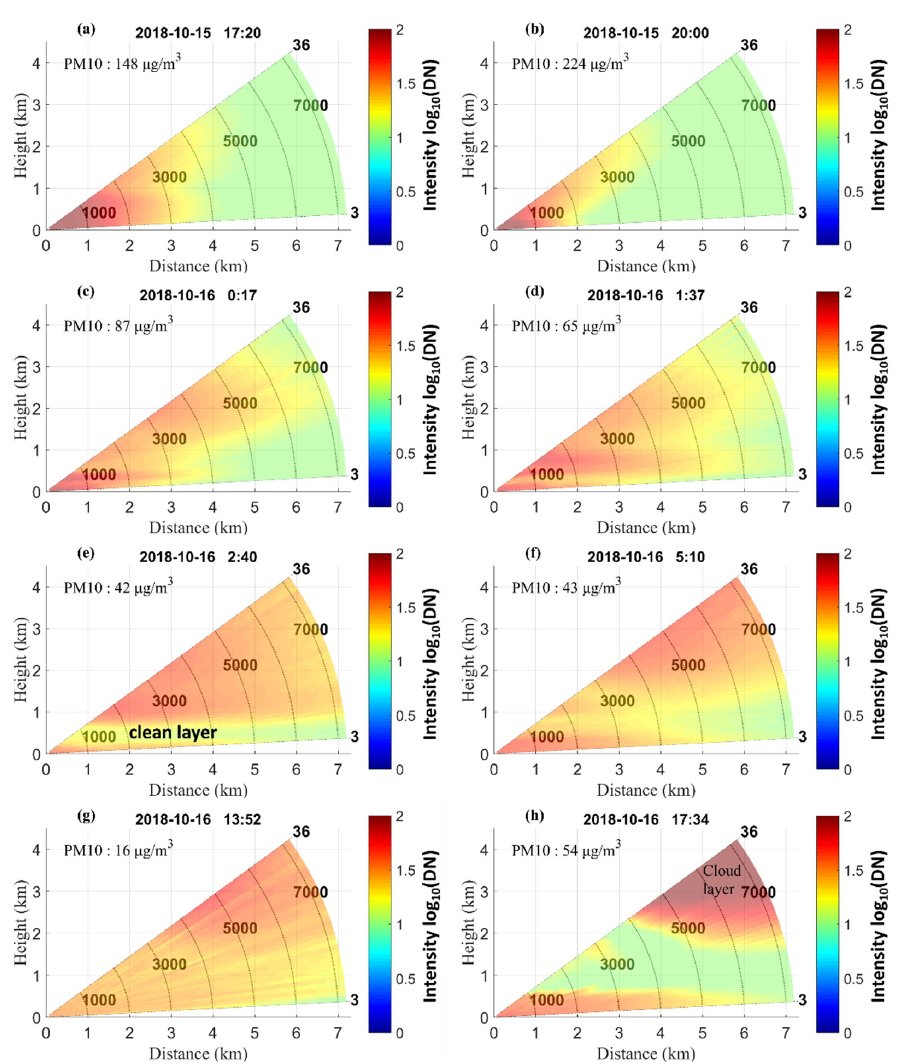
Figure 8 Vertical scanning map of the received signal intensities recorded at (a) 17:20, 15 October, (b) 20:00, 15 October, (c) 00:17, 16 October, (d) 01:37, 16 October, (e) 02:40 16 October, (f) 05:10 16 October, (g) 13:52 16 October, (h) 17:34 16 October. The lidar signals were plotted in log-scale. The PM10 concentrations were measured by the Xinghai national pollution monitoring station. Location of the lidar system: 38˚53′00.7″N, 121˚31′37.2″E. Zenith scanning range: 3 ° -36 ° . The local times indicated in